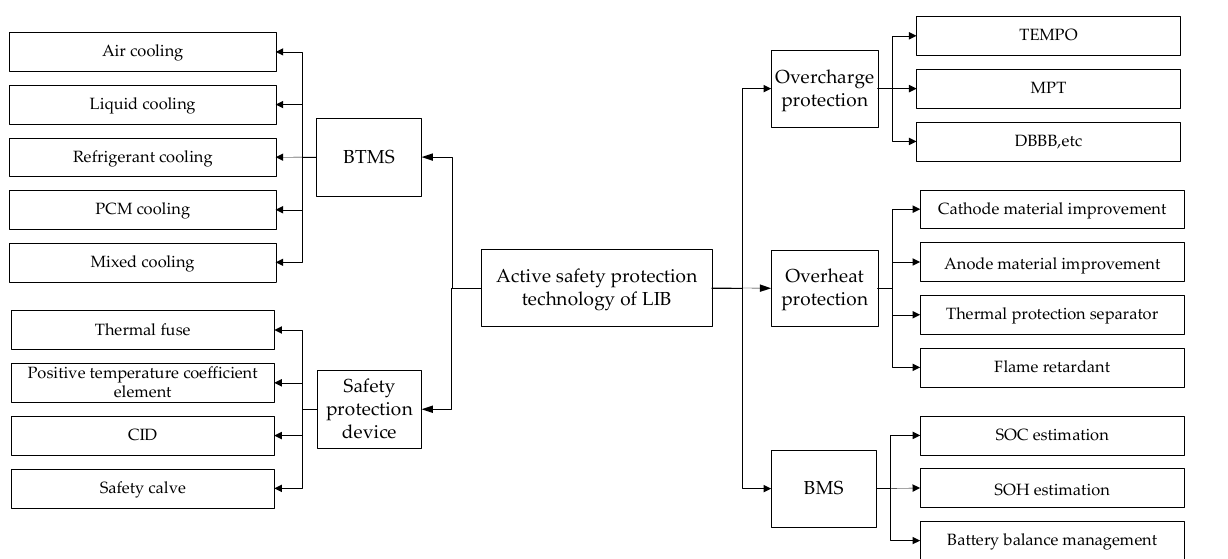
Figure 14. Active safety protection technology of